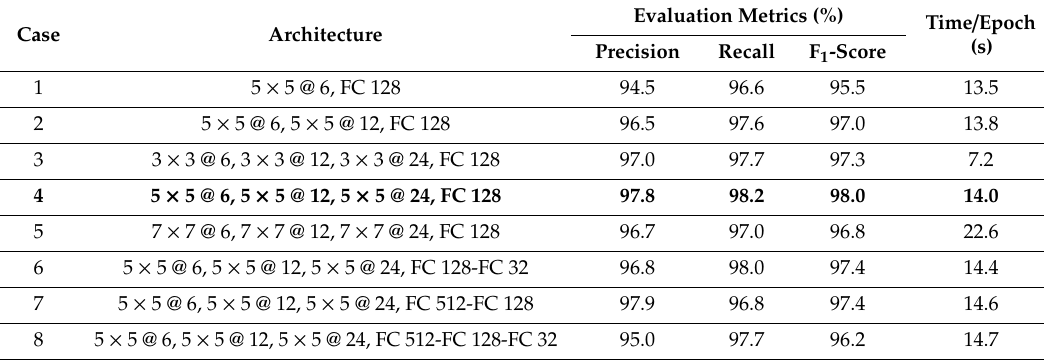
Table 3. Arching detection performance of di ff erent CNN architectures.